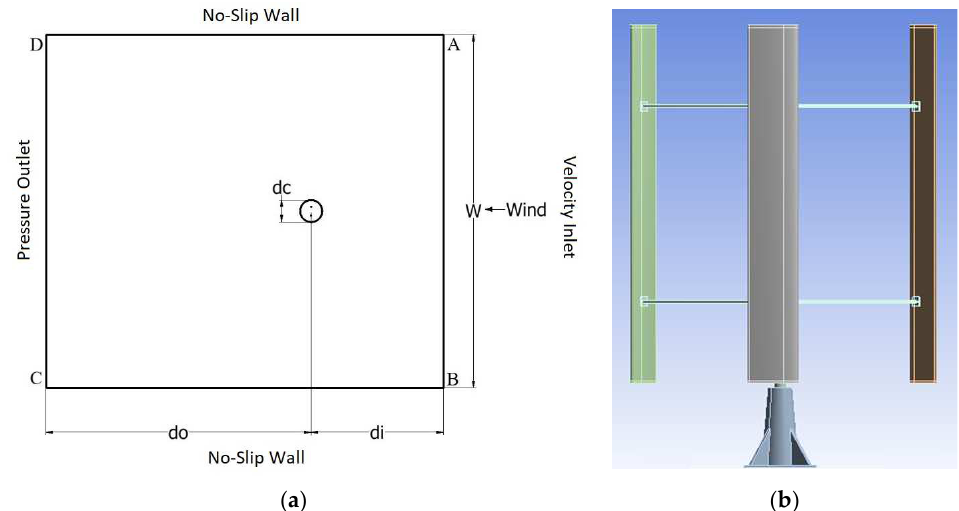
Figure 2. ( a ) Computational domain ABCD; ( b ) A representation of straight-bladed VAWT with 3 blades.